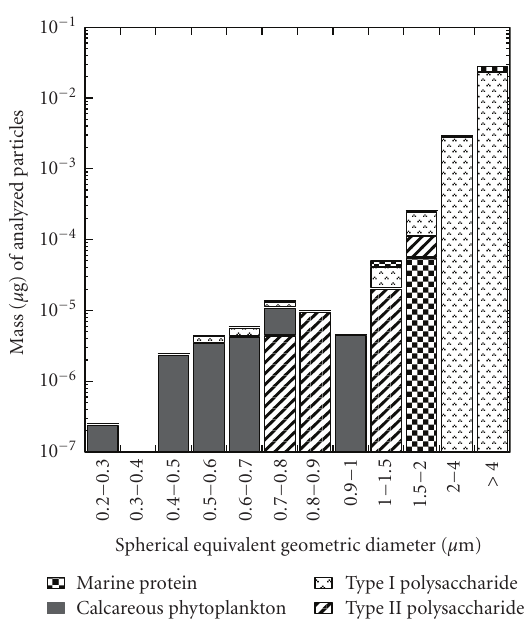
Figure 7: Estimated mass of marine particle types from both Arctic and Pacific